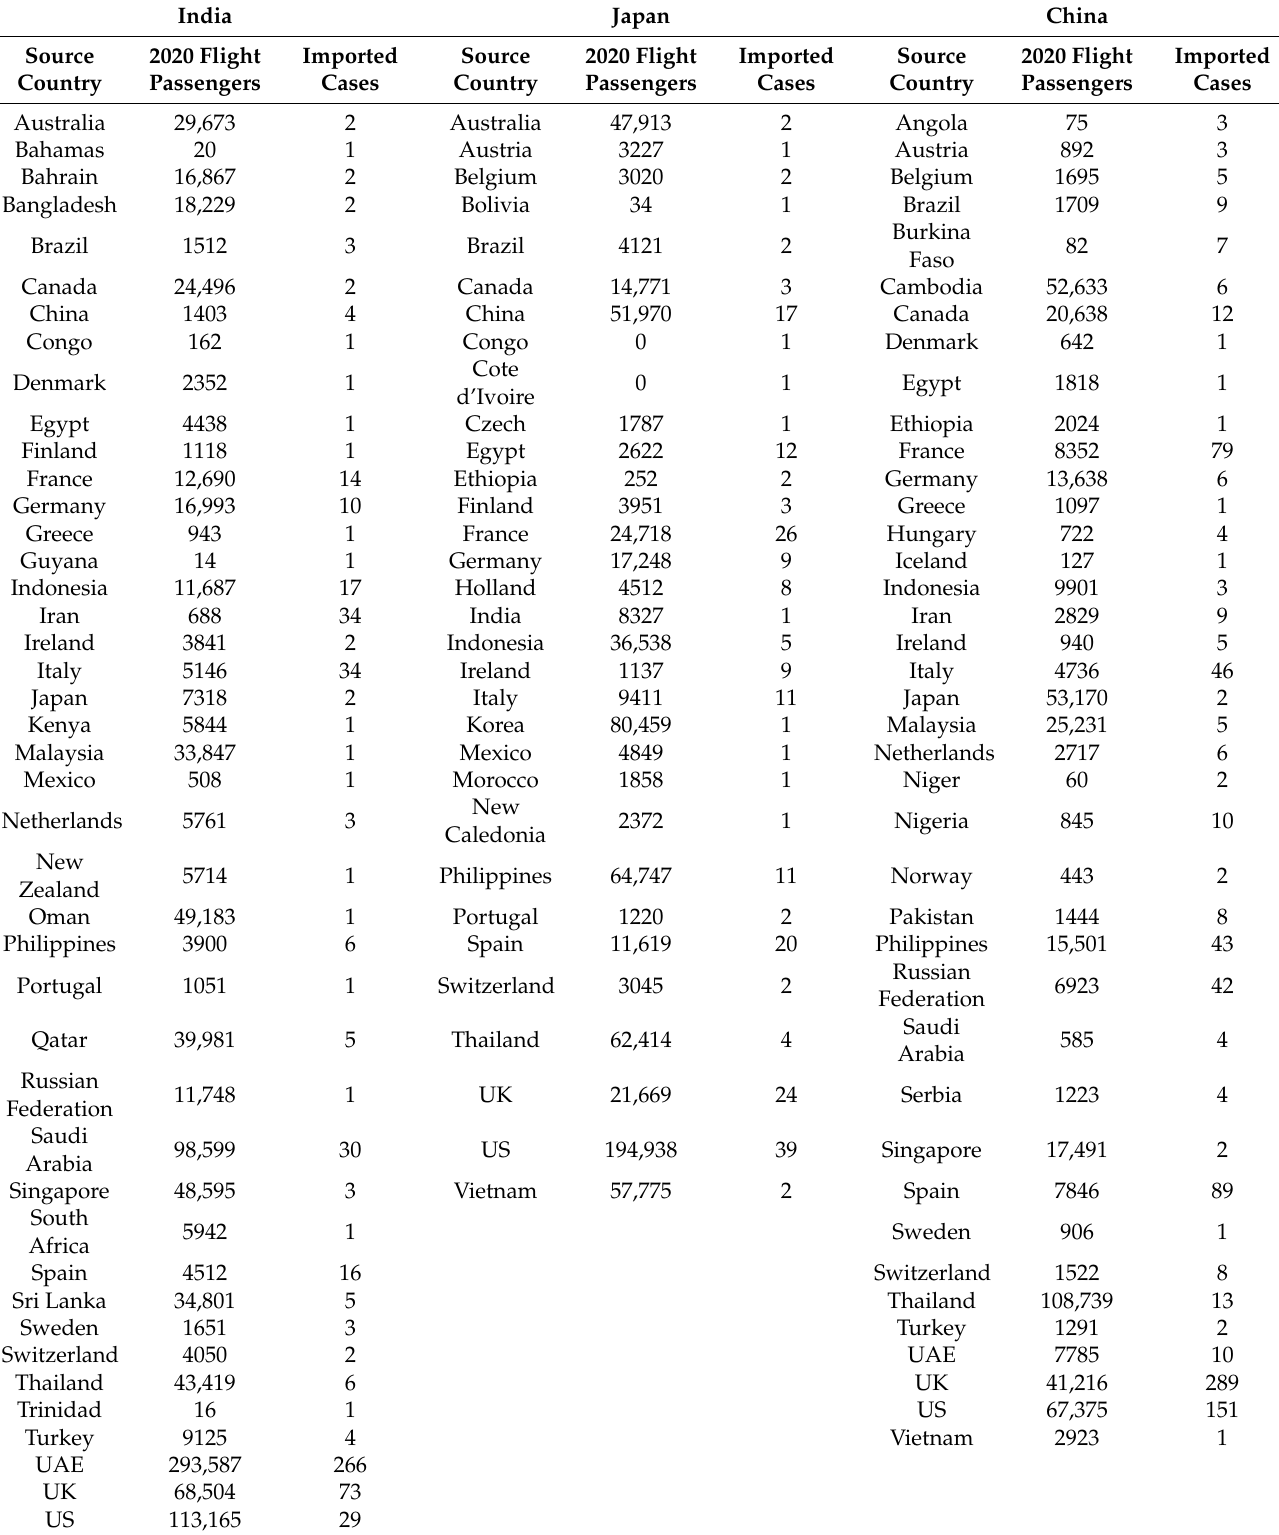
Table A1. Inbound Flight passengers and imported cases from different source countries to India, Japan, and China in